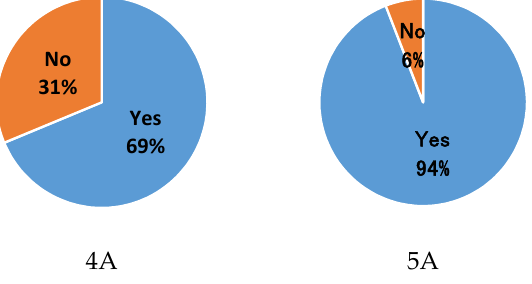
Figure 4. Results of questionnaire item “Did you open a window or turn on ventilation when the display alerted you?”.